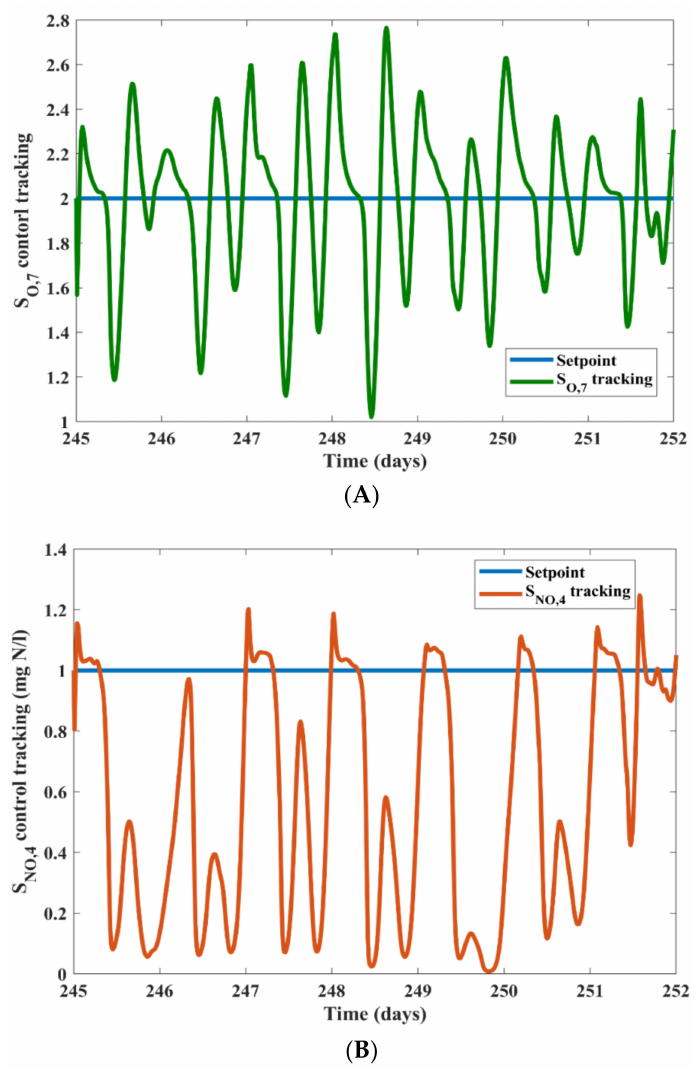
Figure 2. Set-point tracking for: ( A ) dissolved oxygen and ( B )